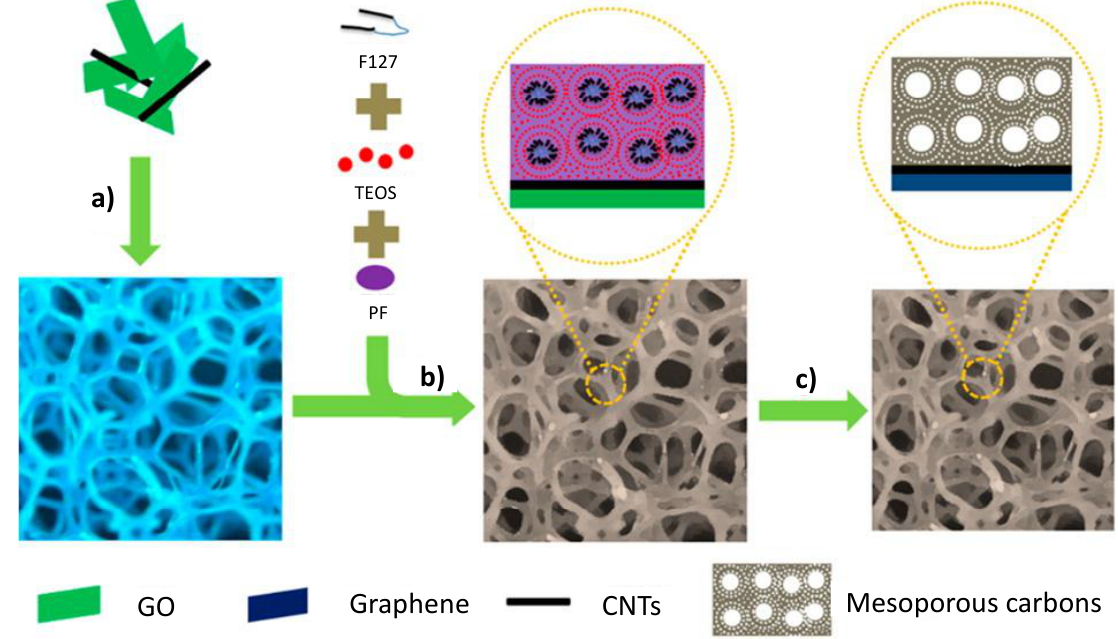
Figure 2. Fabrication of 3D hierarchically porous carbon–CNT–graphene ternary all-carbon foams (3D-HPCFs): ( a ) Impregnating sponge into the GOC solution; ( b ) Impregnating